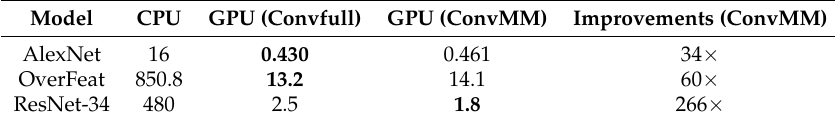
Table 7. Energy consumption of deep models (J), best results are written in